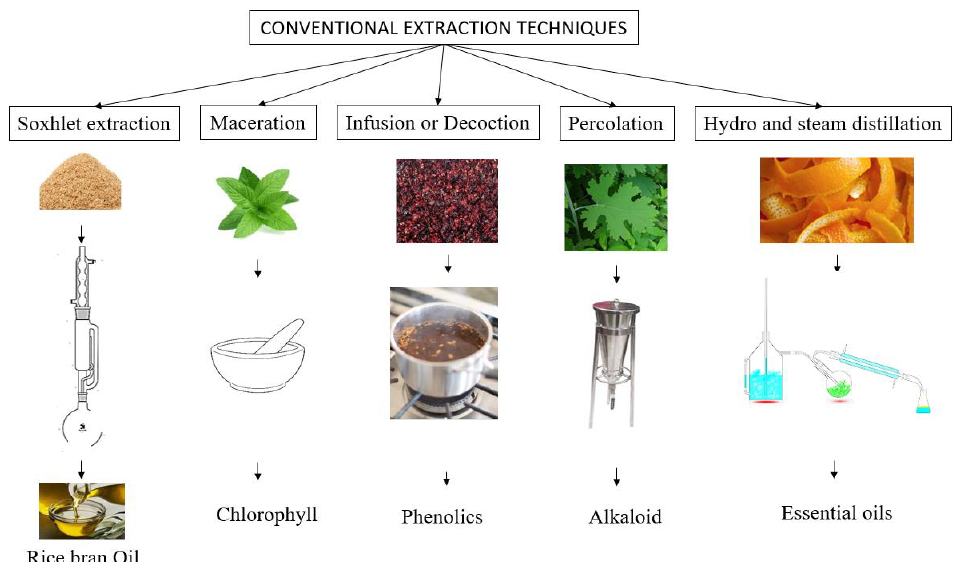
Figure 5. Schematic illustration of various conventional methods of extraction of bioactives or useful materials from different food wastes.